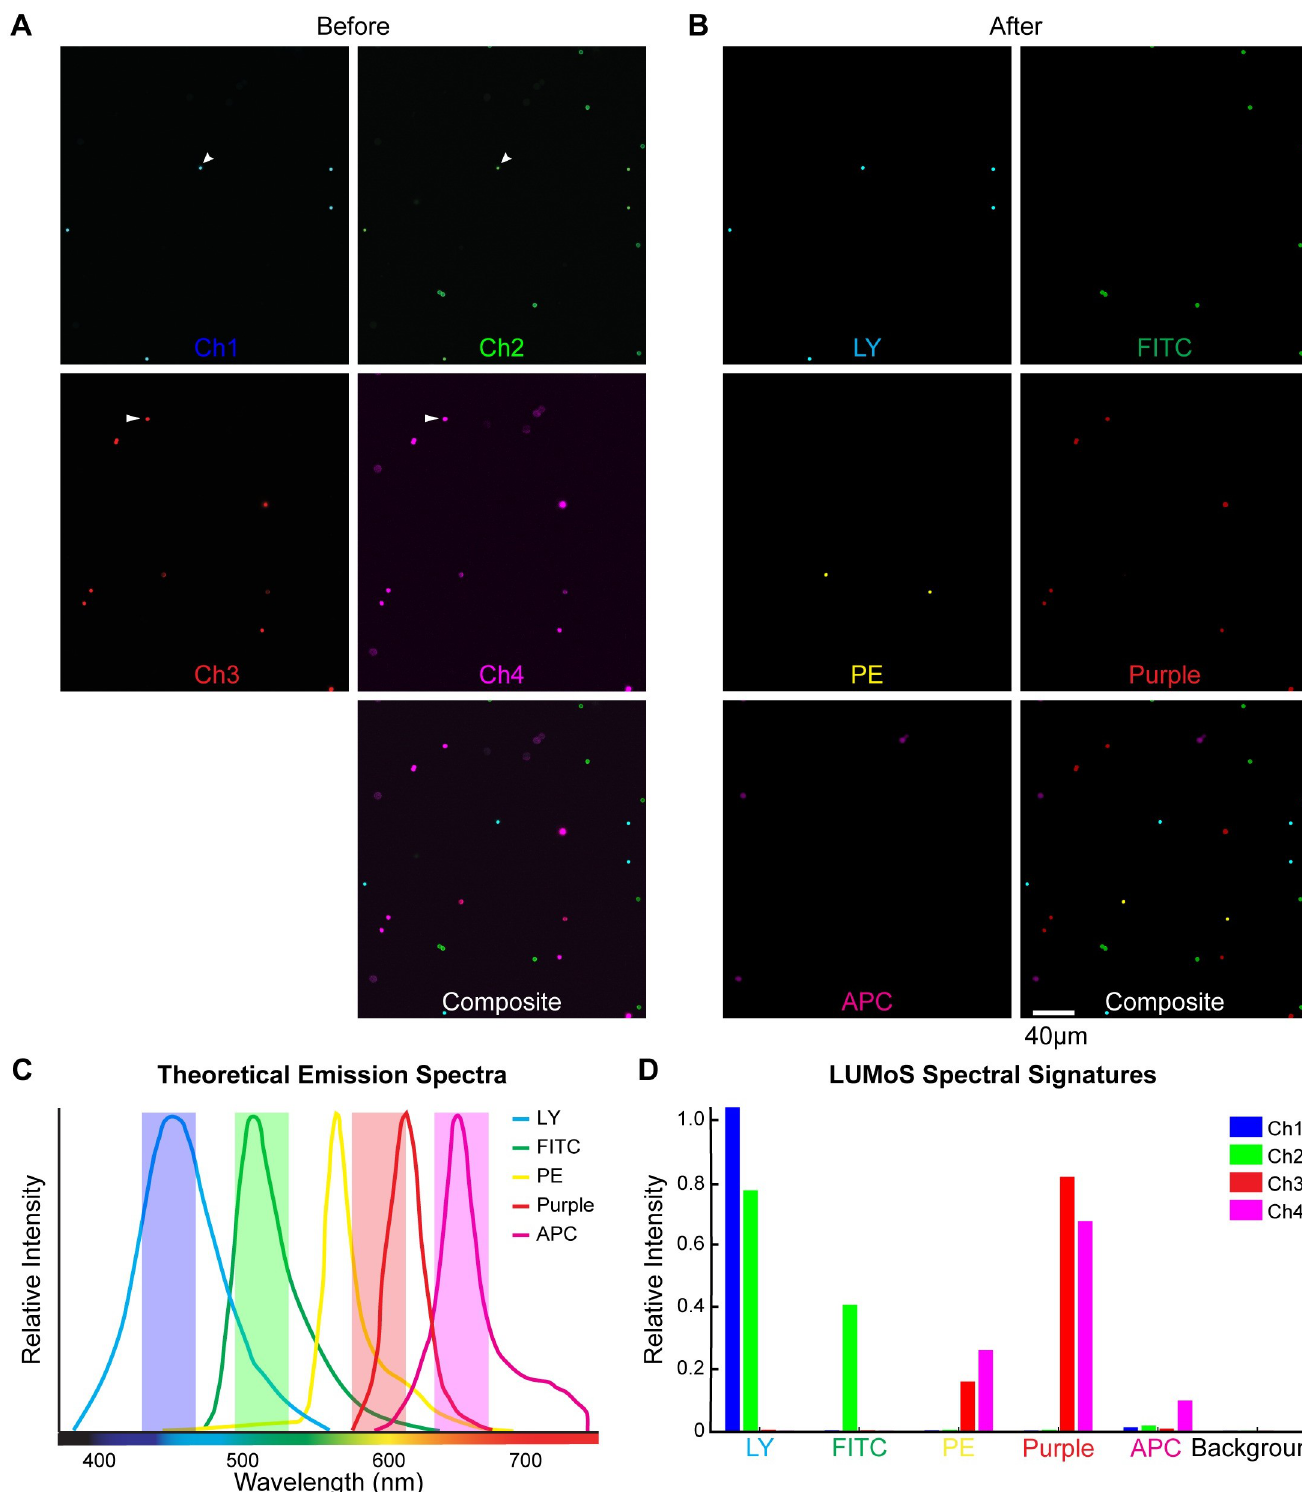
Fig 4. LUMoS unmixing of 5-color beads mixed in 4 detection channels. (A) Mixed beads stained with Light Yellow (LY), FITC, PE, Purple, and APC imaged with 2PLSM. LY and Purple are special dyes by Spherotech. It was unable to resolve 5 colors with 4 detectors, and there were also beads shown in more than one channels. Two examples are pointed out by white arrows. (B) The images shown in A after processing through LUMoS. The first five images show the fluorescence of the five